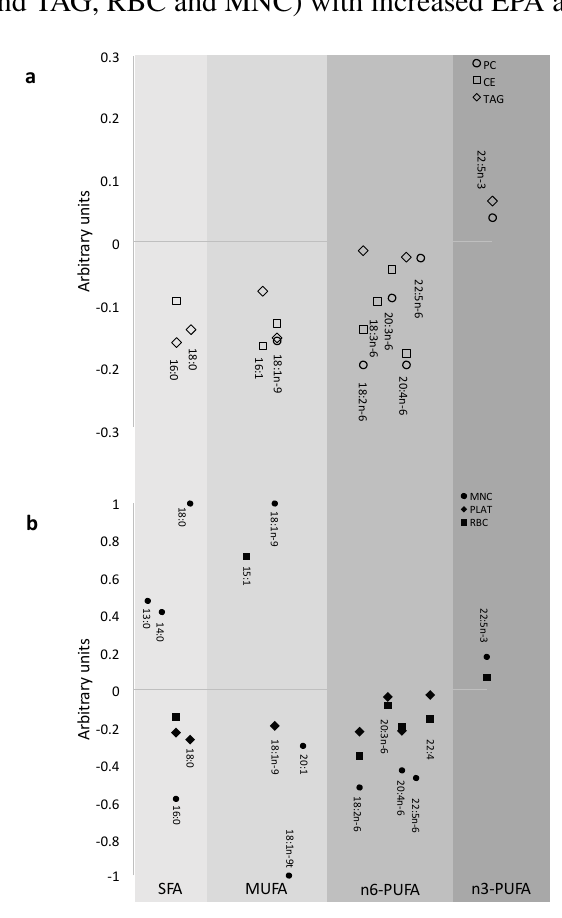
Figure 1. Patterns of modelled changes in fatty acids which occur with the increase in eicosapentaenoic acid (EPA) and docosahexaenoic acid (DHA) in ( a ) plasma and ( b ) blood cell fatty acid pools. Linear combinations of the co-efficients from the multinomial linear regression models were calculated for each fatty acid important for the change in EPA + DHA. As a small regression coefficient for the fatty acid of interest reflected a large change in the outcomes EPA + DHA and vice versa the data are the reciprocal of the co-efficients in order to portray the magnitude of effect, and this is presented in arbitrary units. Fatty acids are grouped according to class to depict the patterns of change in fatty acids for each pool.